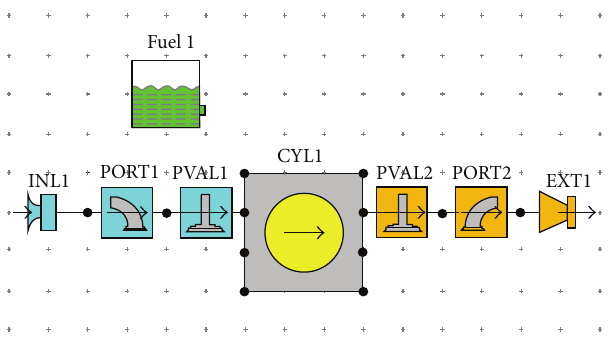
Figure 7: Engine model designed with LESoft.